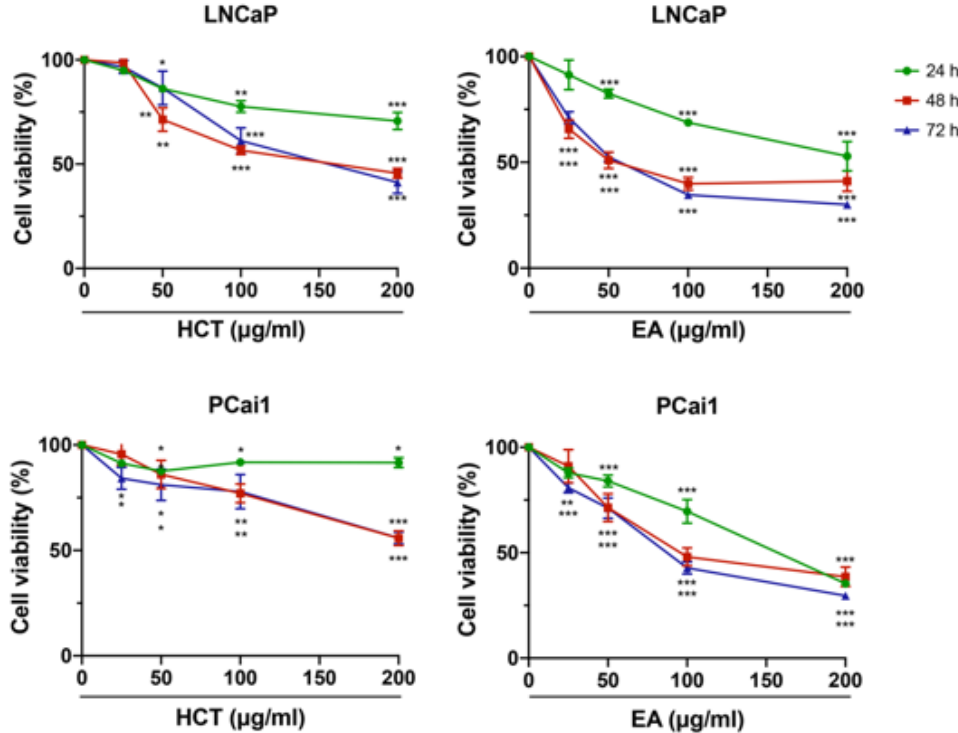
Figure 2. Cytotoxic effects of HCT and EA in prostate cancer cell lines. LNCaP and PCai1 cells were treated with HCT or EA (25–200 µ g/mL) at 24, 48, and 72 h. The data represent three independent experiments. * p < 0.05; ** p < 0.01; *** p < 0.001 vs. control (one-way ANOVA with Tukey’s post hoc test).